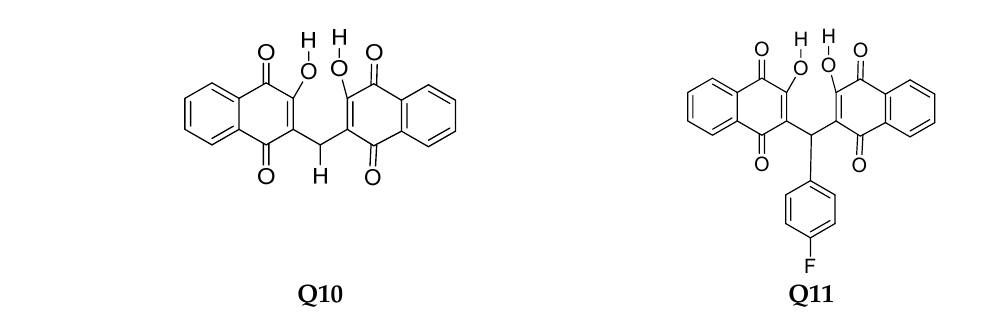
Figure 1. Molecular structures of hydrazone and quinone derivatives. Table 2. In vitro susceptibility ( µ g/mL) of the six isolated Sporothrix brasiliensis (yeast forms) to the novel hydrazone derivatives.